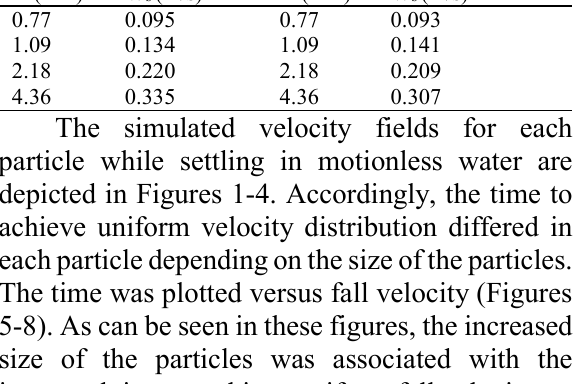
Table 2. The Numerical and experimental results of fall velocity Numerical results